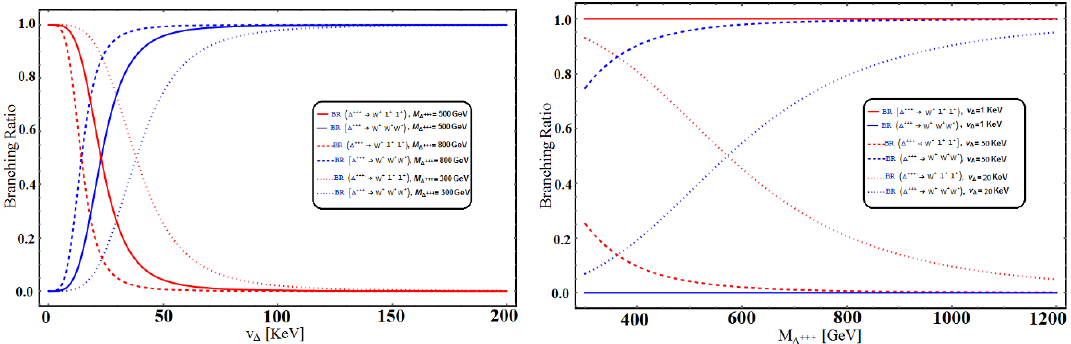
Figure 10 . Left : variation of branching ratio (Br) for di(cid:11)erent decay modes of (cid:1) (cid:6)(cid:6)(cid:6) as a function of vev v (cid:1) for M = 300 (Dotted), 800 (Dashed) and 500 (Solid) GeV. Right : variation of (cid:1) (cid:6)(cid:6)(cid:6) branching ratio (Br) for di(cid:11)erent decay modes of (cid:1) (cid:6)(cid:6)(cid:6) as a function of mass M KeV (dotted), 100 KeV (dashed) and 1 KeV (Solid). Red and blue lines are for W + l + l + decay and W + W + W + decay